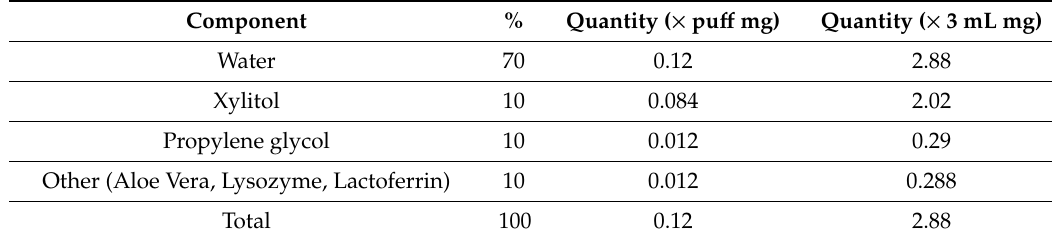
Table 1. Aldiamed ® spray main component / pu ff